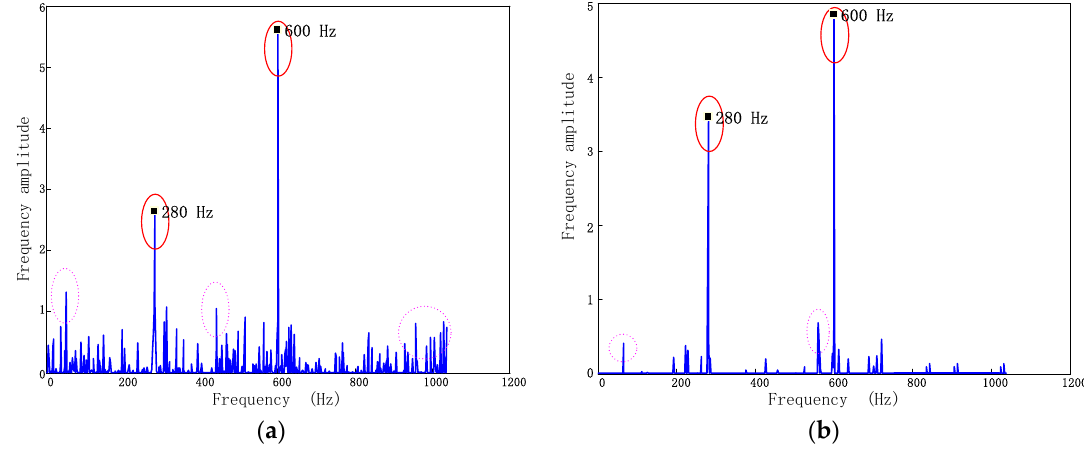
Figure 8. Comparison of frequency recovery of biased BTT data ( a ) Frequency spectrum recovered by 𝑨 𝟏 ≈ 2:1 ) ( b ) Frequency spectrum recovered by BPDN( β = 56.03%, 𝑨 𝟏 BP( β = 31.29%, 𝑨 𝟐